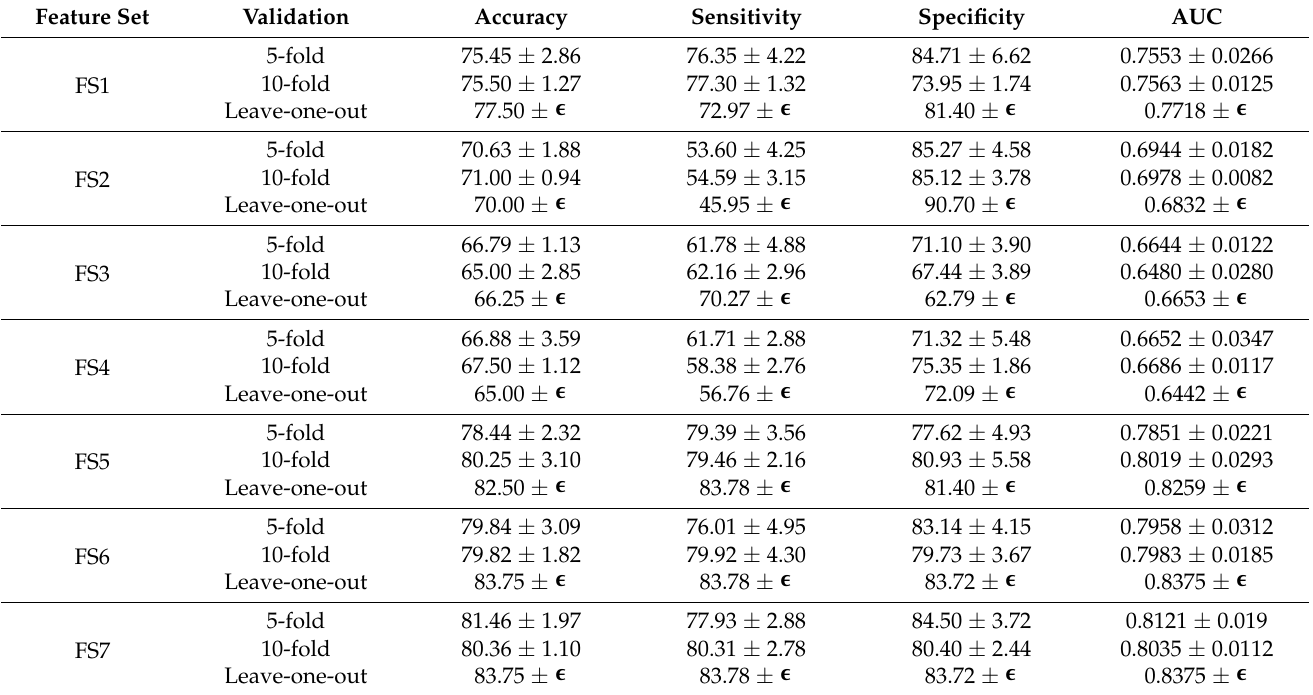
Table 7. Comparison of experimental results of classification accuracy (%), sensitivity (%), specificity Table 4. Comparison of experimental results of classification accuracy (%), sensitivity (%), specific- ity (%), and AUC (in terms of mean ± standard deviation) using the proposed SVM classification model, where 𝛜 indicates 1.0 × 10 − 5 . Table 4. Comparison of experimental results of classification accuracy (%), sensitivity (%), specific- Table 4. Comparison of experimental results of classification accuracy (%), sensitivity (%), specific- ity (%), and AUC (in terms of mean ± standard deviation) using the proposed SVM classification Table 4. Comparison of experimental results of classification accuracy (%), sensitivity (%), specific- Table 4. Comparison of experimental results of classification accuracy (%), sensitivity (%), specific- Table 4. Comparison of experimental results of classification accuracy (%), sensitivity (%), specific- Table 4. Comparison of experimental results of classification accuracy (%), sensitivity (%), specific- ity (%), and AUC (in terms of mean ± standard deviation) using the proposed SVM classification model, where 𝛜 indicates 1.0 × 10 − 5 . ity (%), and AUC (in terms of mean ± standard deviation) using the proposed SVM classification ity (%), and AUC (in terms of mean ± standard deviation) using the proposed SVM classification ity (%), and AUC (in terms of mean ± standard deviation) using the proposed SVM classification ity (%), and AUC (in terms of mean ± standard deviation) using the proposed SVM classification model, where 𝛜 indicates 1.0 × 10 − 5 . model, where 𝛜 indicates 1.0 × 10 − 5 . model, where 𝛜 indicates 1.0 × 10 − 5 . model, where 𝛜 indicates 1.0 × 10 − 5 . model, where 𝛜 indicates 1.0 × 10 − 5 . Table 4. Comparison of experimental results of classification accuracy (%), sensitivity (%), specific- Table 4. Comparison of experimental results of classification accuracy (%), sensitivity (%), specific- Table 4. Comparison of experimental results of classification accuracy (%), sensitivity (%), specific- Table 4. Comparison of experimental results of classification accuracy (%), sensitivity (%), specific- ity (%), and AUC (in terms of mean ± standard deviation) using the proposed SVM classification ity (%), and AUC (in terms of mean ± standard deviation) using the proposed SVM classification ity (%), and AUC (in terms of mean ± standard deviation) using the proposed SVM classification ity (%), and AUC (in terms of mean ± standard deviation) using the proposed SVM classification model, where 𝛜 indicates 1.0 × 10 − 5 . model, where 𝛜 indicates 1.0 × 10 − 5 . model, where 𝛜 indicates 1.0 × 10 − 5 . model, where 𝛜 indicates 1.0 × 10 − 5 . Table 4. Comparison of experimental results of classification accuracy (%), sensitivity (%), specific- Table 4. Comparison of experimental results of classification accuracy (%), sensitivity (%), specific- Table 4. Comparison of experimental results of classification accuracy (%), sensitivity (%), specific- Table 4. Comparison of experimental results of classification accuracy (%), sensitivity (%), specific- ity (%), and AUC (in terms of mean ± standard deviation) using the proposed SVM classification ity (%), and AUC (in terms of mean ± standard deviation) using the proposed SVM classification ity (%), and AUC (in terms of mean ± standard deviation) using the proposed SVM classification ity (%), and AUC (in terms of mean ± standard deviation) using the proposed SVM classification Table 4. Comparison of experimental results of classification accuracy (%), sensitivity (%), specific- model, where 𝛜 indicates 1.0 × 10 − 5 . model, where 𝛜 indicates 1.0 × 10 − 5 . model, where 𝛜 indicates 1.0 × 10 − 5 . model, where 𝛜 indicates 1.0 × 10 − 5 . Table 4. Comparison of experimental results of classification accuracy (%), sensitivity (%), specific- ity (%), and AUC (in terms of mean ± standard deviation) using the proposed SVM classification Table 4. Comparison of experimental results of classification accuracy (%), sensitivity (%), specific- Table 4. Comparison of experimental results of classification accuracy (%), sensitivity (%), specific- Table 4. Comparison of experimental results of classification accuracy (%), sensitivity (%), specific- Table 4. Comparison of experimental results of classification accuracy (%), sensitivity (%), specific- ity (%), and AUC (in terms of mean ± standard deviation) using the proposed SVM classification model, where 𝛜 indicates 1.0 × 10 − 5 . ity (%), and AUC (in terms of mean ± standard deviation) using the proposed SVM classification ity (%), and AUC (in terms of mean ± standard deviation) using the proposed SVM classification ity (%), and AUC (in terms of mean ± standard deviation) using the proposed SVM classification ity (%), and AUC (in terms of mean ± standard deviation) using the proposed SVM classification model, where 𝛜 indicates 1.0 × 10 − 5 . model, where 𝛜 indicates 1.0 × 10 − 5 . model, where 𝛜 indicates 1.0 × 10 − 5 . model, where 𝛜 indicates 1.0 × 10 − 5 . model, where 𝛜 indicates 1.0 × 10 − 5 . Table 4. Comparison of experimental results of classification accuracy (%), sensitivity (%), specific- Table 4. Comparison of experimental results of classification accuracy (%), sensitivity (%), specific- Table 4. Comparison of experimental results of classification accuracy (%), sensitivity (%), specific- Table 4. Comparison of experimental results of classification accuracy (%), sensitivity (%), specific- ity (%), and AUC (in terms of mean ± standard deviation) using the proposed SVM classification ity (%), and AUC (in terms of mean ± standard deviation) using the proposed SVM classification ity (%), and AUC (in terms of mean ± standard deviation) using the proposed SVM classification ity (%), and AUC (in terms of mean ± standard deviation) using the proposed SVM classification model, where 𝛜 indicates 1.0 × 10 − 5 . model, where 𝛜 indicates 1.0 × 10 − 5 . model, where 𝛜 indicates 1.0 × 10 − 5 . model, where 𝛜 indicates 1.0 × 10 − 5 . Table 4. Comparison of experimental results of classification accuracy (%), sensitivity (%), specific- Table 4. Comparison of experimental results of classification accuracy (%), sensitivity (%), specific- Table 4. Comparison of experimental results of classification accuracy (%), sensitivity (%), specific- Table 4. Comparison of experimental results of classification accuracy (%), sensitivity (%), specific- ity (%), and AUC (in terms of mean ± standard deviation) using the proposed SVM classification ity (%), and AUC (in terms of mean ± standard deviation) using the proposed SVM classification ity (%), and AUC (in terms of mean ± standard deviation) using the proposed SVM classification ity (%), and AUC (in terms of mean ± standard deviation) using the proposed SVM classification Table 4. Comparison of experimental results of classification accuracy (%), sensitivity (%), specific- model, where 𝛜 indicates 1.0 × 10 − 5 . model, where 𝛜 indicates 1.0 × 10 − 5 . model, where 𝛜 indicates 1.0 × 10 − 5 . model, where 𝛜 indicates 1.0 × 10 − 5 . Table 4. Comparison of experimental results of classification accuracy (%), sensitivity (%), specific- ity (%), and AUC (in terms of mean ± standard deviation) using the proposed SVM classification Table 4. Comparison of experimental results of classification accuracy (%), sensitivity (%), specific- Table 4. Comparison of experimental results of classification accuracy (%), sensitivity (%), specific- Table 4. Comparison of experimental results of classification accuracy (%), sensitivity (%), specific- Table 4. Comparison of experimental results of classification accuracy (%), sensitivity (%), specific- ity (%), and AUC (in terms of mean ± standard deviation) using the proposed SVM classification model, where 𝛜 indicates 1.0 × 10 − 5 . ity (%), and AUC (in terms of mean ± standard deviation) using the proposed SVM classification ity (%), and AUC (in terms of mean ± standard deviation) using the proposed SVM classification ity (%), and AUC (in terms of mean ± standard deviation) using the proposed SVM classification ity (%), and AUC (in terms of mean ± standard deviation) using the proposed SVM classification model, where 𝛜 indicates 1.0 × 10 − 5 . model, where 𝛜 indicates 1.0 × 10 − 5 . model, where 𝛜 indicates 1.0 × 10 − 5 . model, where 𝛜 indicates 1.0 × 10 − 5 . model, where 𝛜 indicates 1.0 × 10 − 5